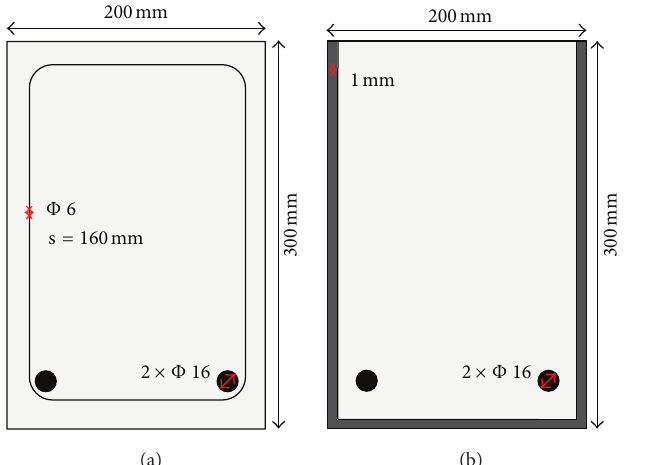
Figure 2: (a) Fully steel reinforced reference beam; (b) composite beam with longitudinal steel reinforcement and HPFRCC IPC formwork as shear